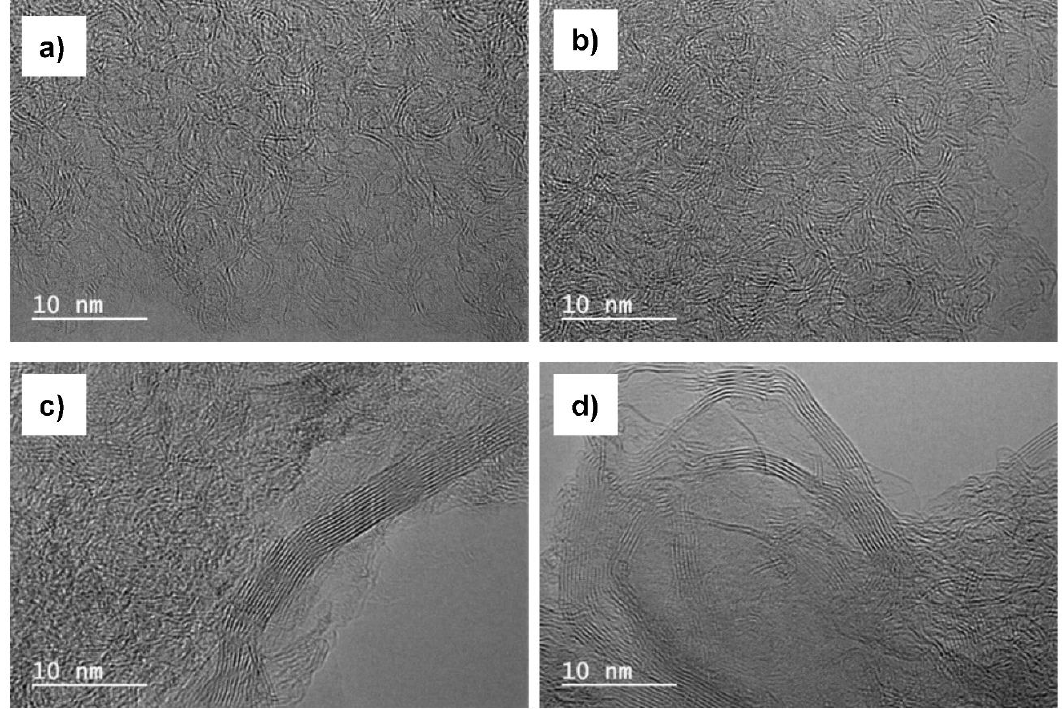
Figure 4. TEM images for ( a ) HC_pine_1400, ( b ) HC_beechwood_1400, ( c ) HC_miscanthus_1400, and ( d ) HC_wheat-straw_1400.